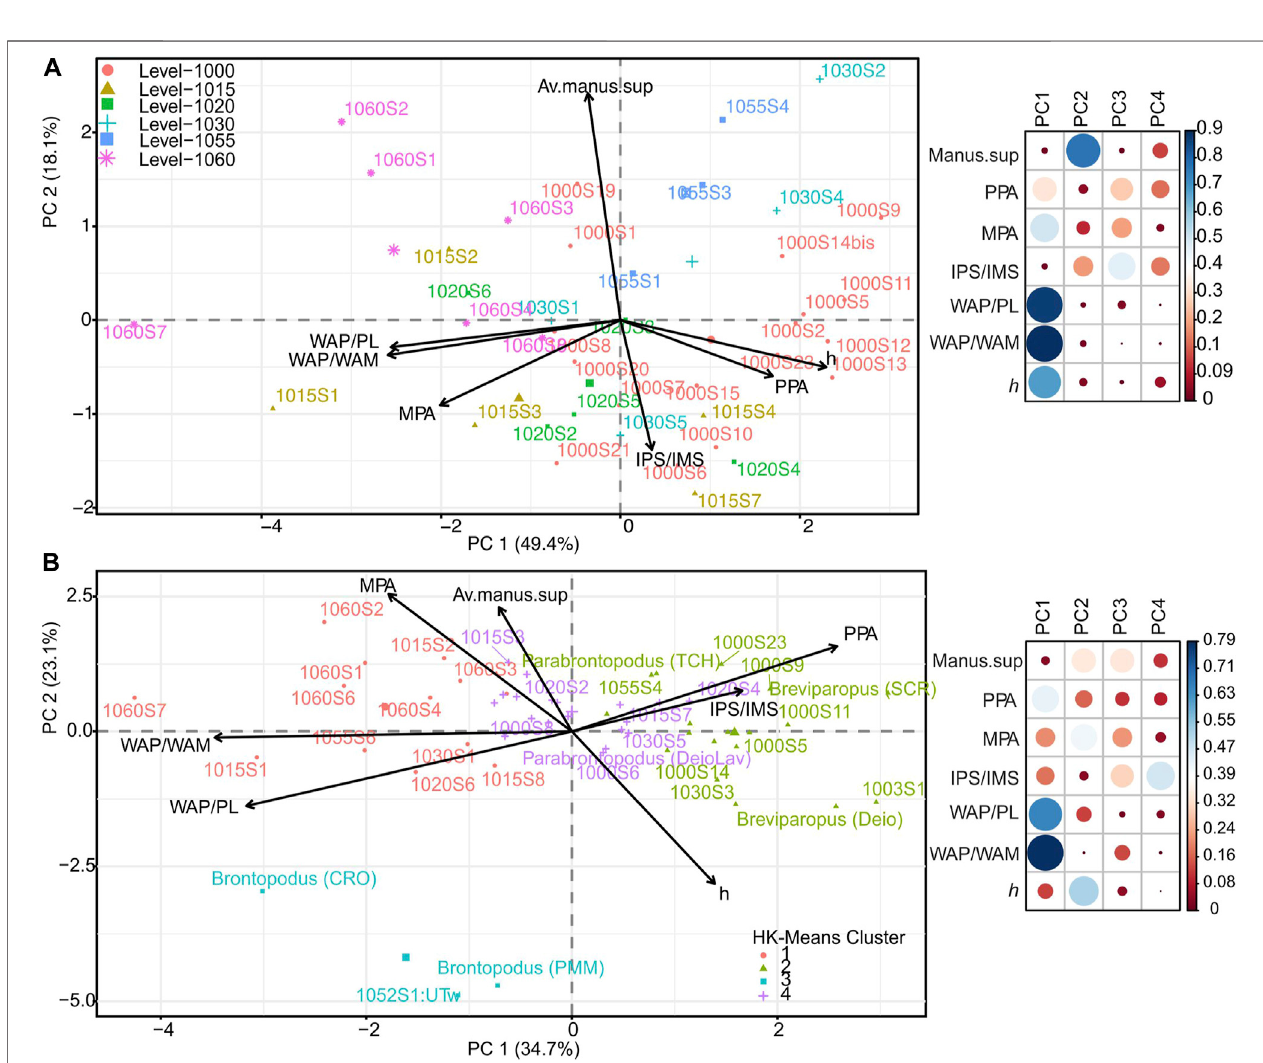
FIGURE 6 | (A) Biplot analysis for trackway similarity. (B) TCH data overlaid with that of Marty et al. (2010). Highly correlated trackway components show vectors pointedinthesamedirection.ThemapstotherightofthebiplotsreferencethequalityofrepresentationofeachvariabletothePCs(i.e.,thesquaredcosine,cos 2 ,value). Higher cos 2 values (darker blue) for a variable indicates its better representation for that p C. Correlated trackway components and trackway samples are in the same quadrant.